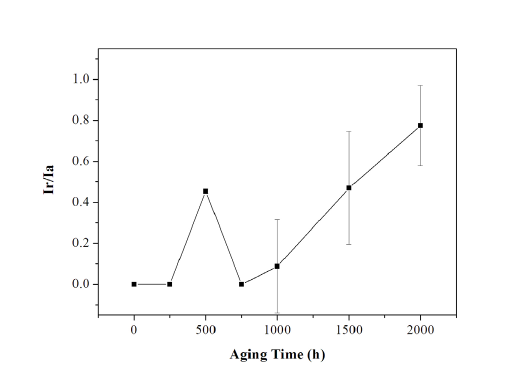
Figure 7. Discontinuous intergranular precipitates aging for 500 h. Image obtained in SEM with (a) 20000X in secondary electron (SE) mode and (b) Precipitate with Mo rich